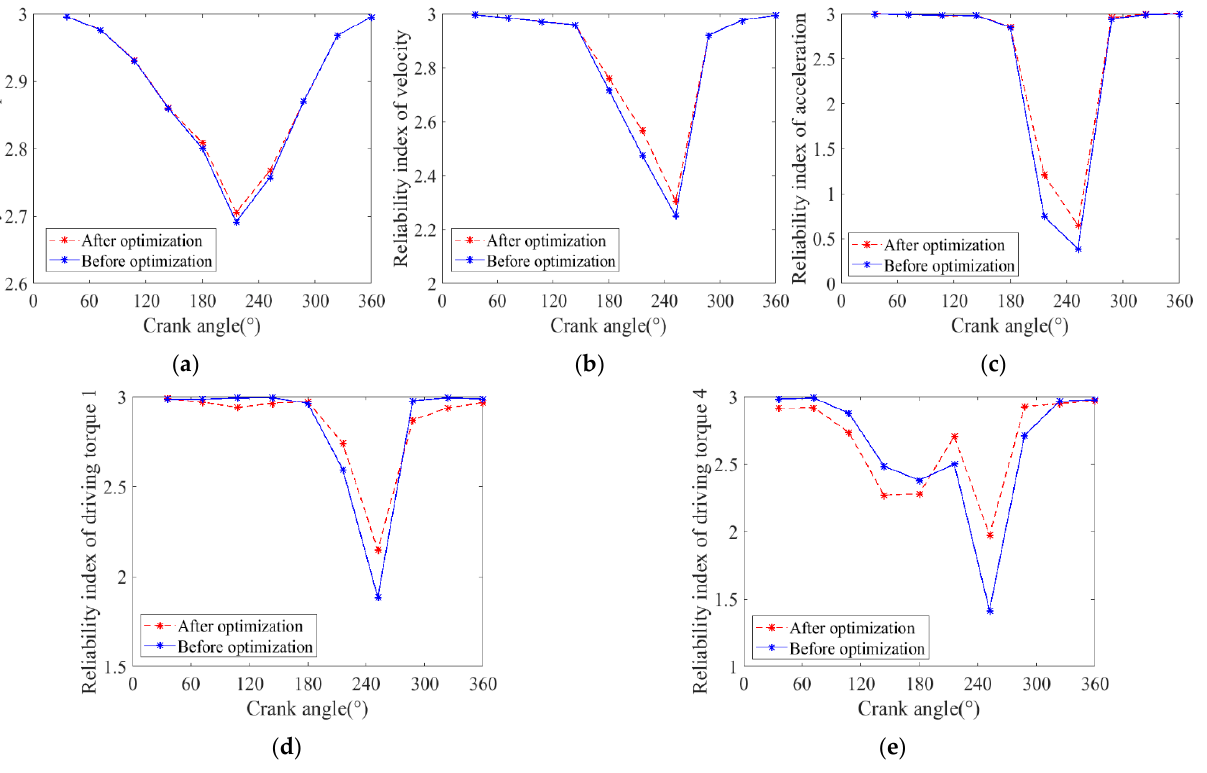
Figure 12. Reliability index. ( a ) Displacement. ( b ) Velocity. ( c ) Acceleration. ( d ) Driving torque of crank 1. ( e ) Driving torque of crank 4.